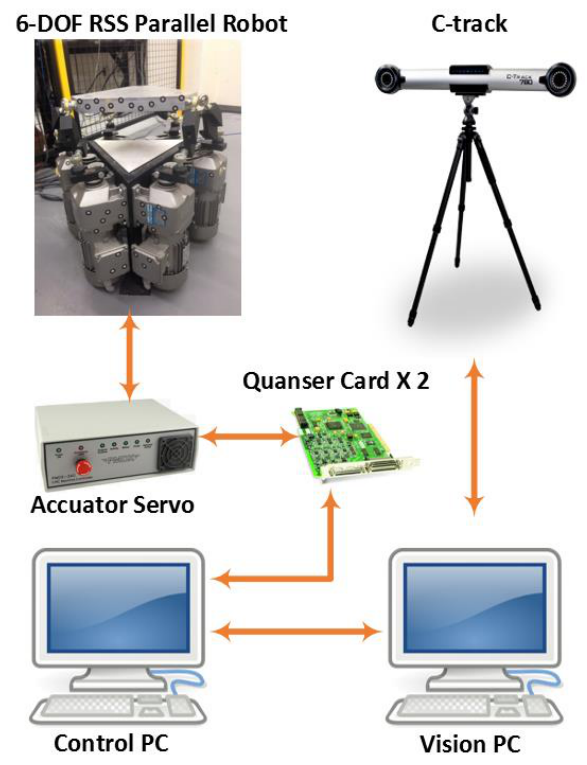
Figure 9. Architecture of the Experiment